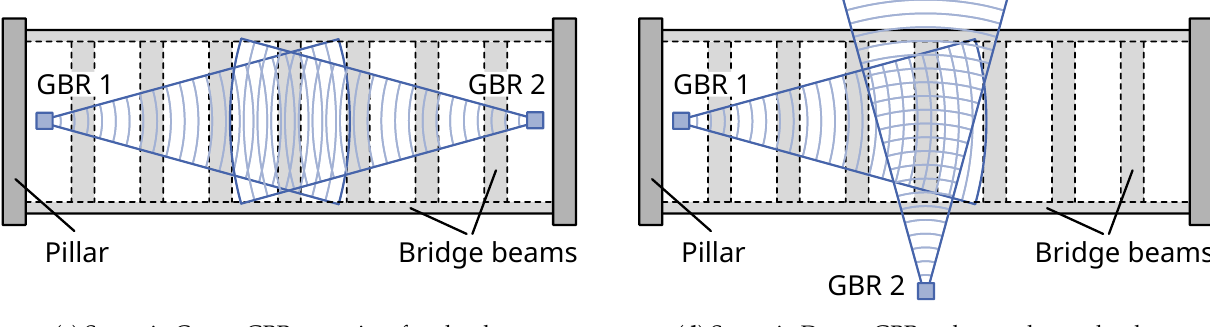
Figure 7. Vertical view of possible measurement setups at a bridge with two longitudinal and consecutive orthogonal